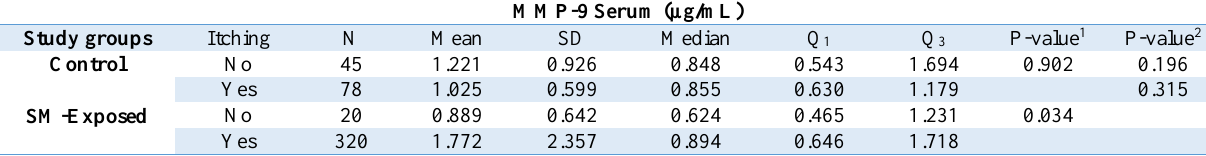
Table 1. MMP-9 in the Control and Sulfur Mustard Exposed Groups With Itching